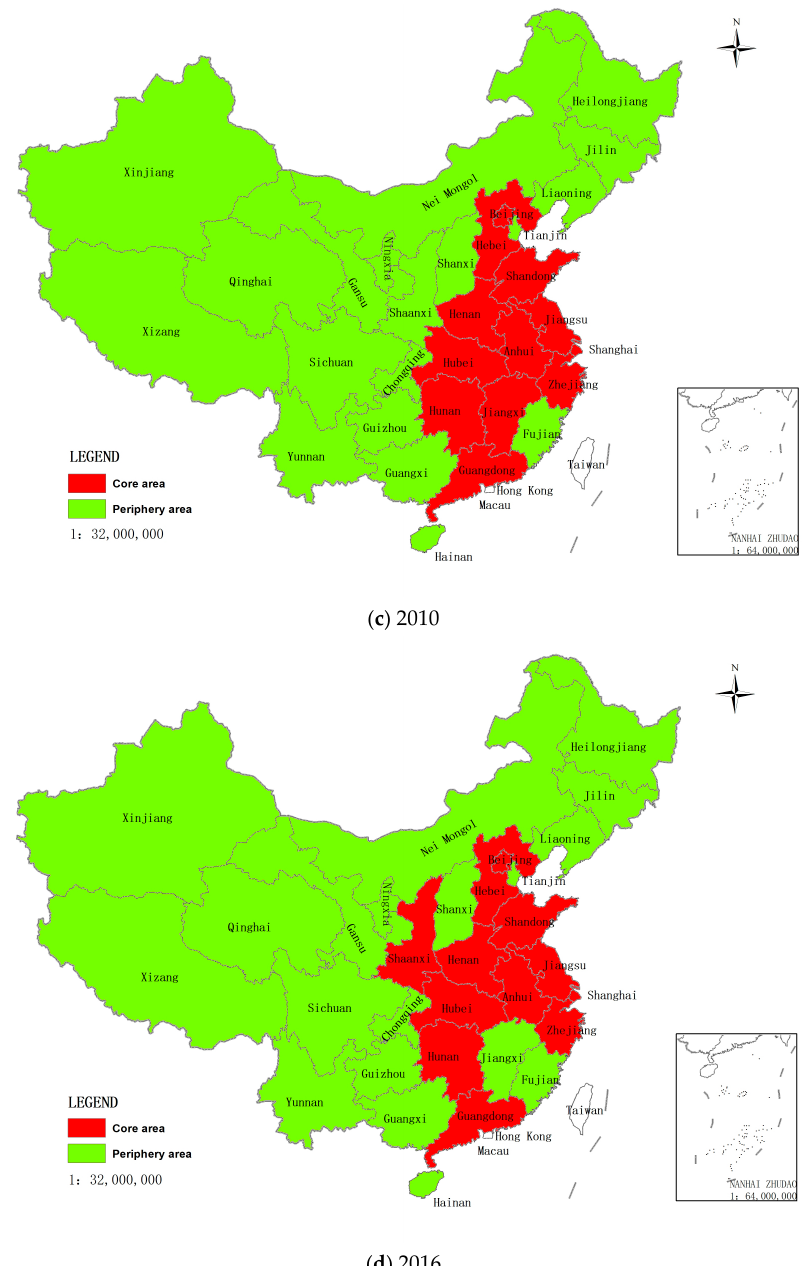
Figure 5. Core-periphery structure of the tourism investment spatial correlation network in China from 2000 to 2016. from 2000 to